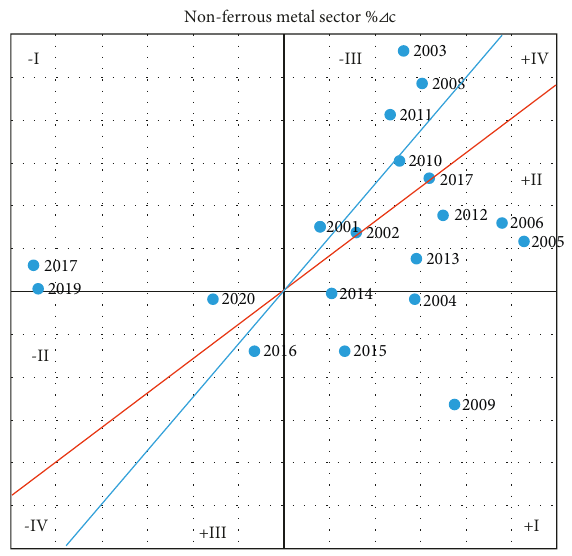
Figure 17: Carbon emission decoupling states of energy con- sumption in the nonferrous metal sector from 2001 to